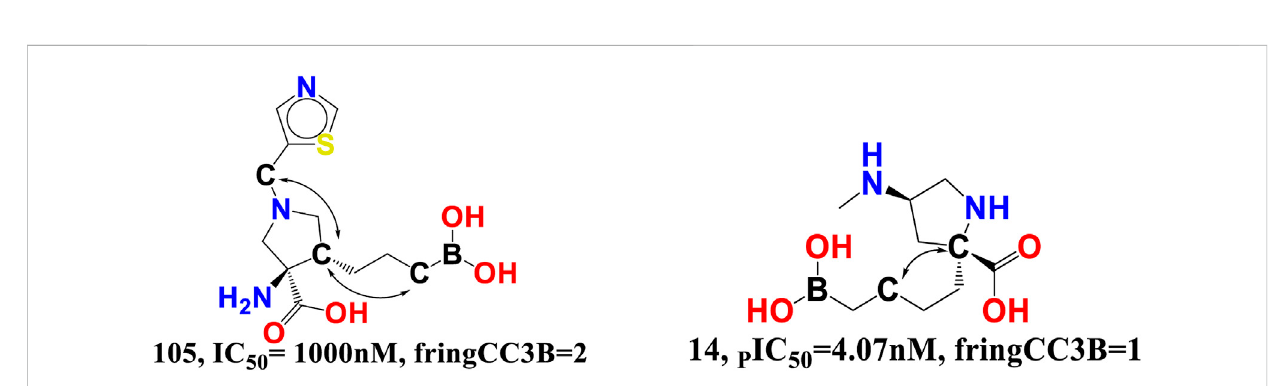
FIGURE 9 Presentation of the molecular descriptor fringCC3B for the molecules 105 and 14